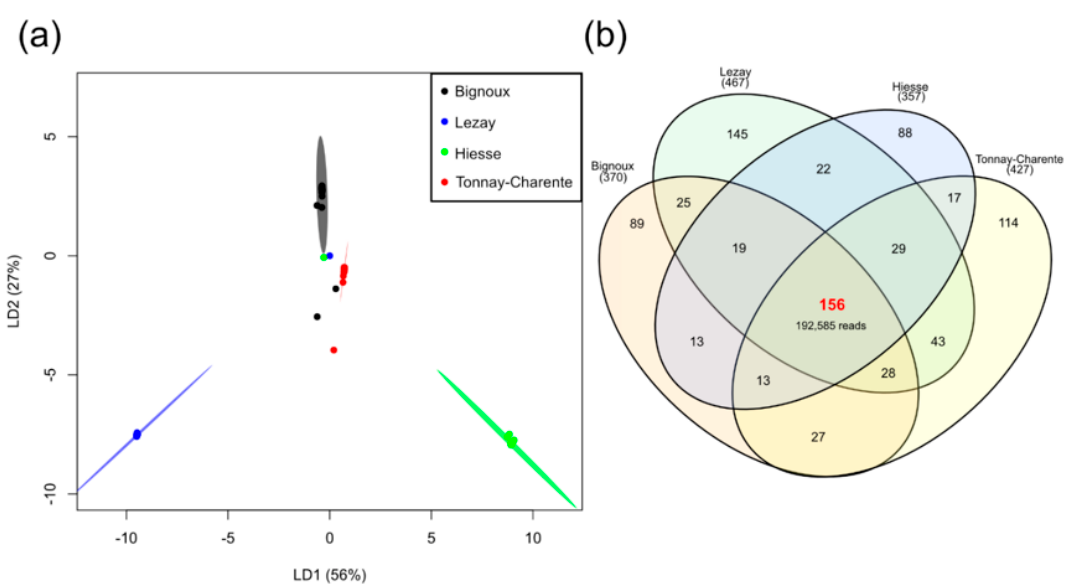
Figure 3. Intra-tick bacterial diversity for each site. ( a ) Site-dependent linear discriminant analysis. Each individual is represented by a single dot. Confidence ellipses were drawn with a confidence of 0.95. These axes were chosen as they depict the best separation between sampling sites; ( b ) Venn diagram of all the taxa identified. Sampling sites Bignoux, Lezay, Hiesse and Tonnay-Charente presented 370, 467, 357 and 427 different taxa, respectively.